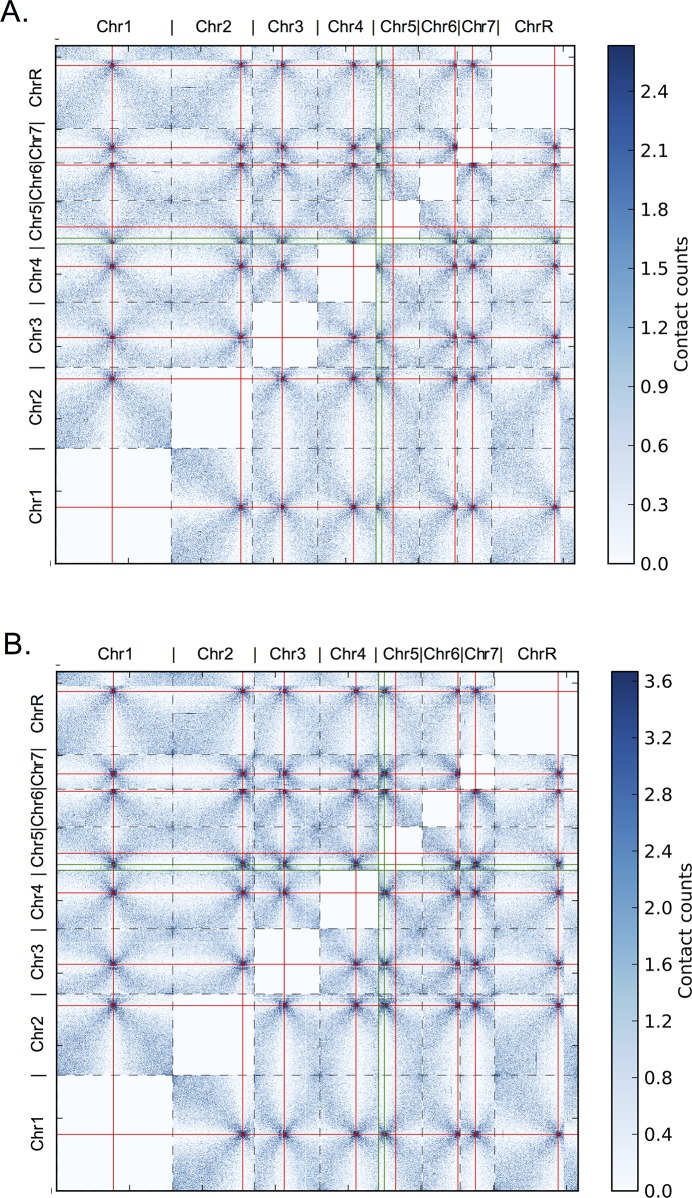
Neocentromere formation results in genome-wide shift of interchromosomal interactions from the native CEN5 region to the neocentromere region.In the heat maps, normalized contacts counts are shown in increasing intensity of blue. Borders of chromosomes are shown with dashed lines. Red lines mark centromeres. Green lines indicate neocentromere positions. A. Heatmap of genome-wide interchromosomal interactions from the Hi-C data of the YJB10777 strain with the active centromere at the 4.5kb neocentromere position. B. Heatmap of genome-wide interchromosomal interactions from the Hi-C data of the YJB10780 strain with the active centromere at the 166kb neocentromere position.